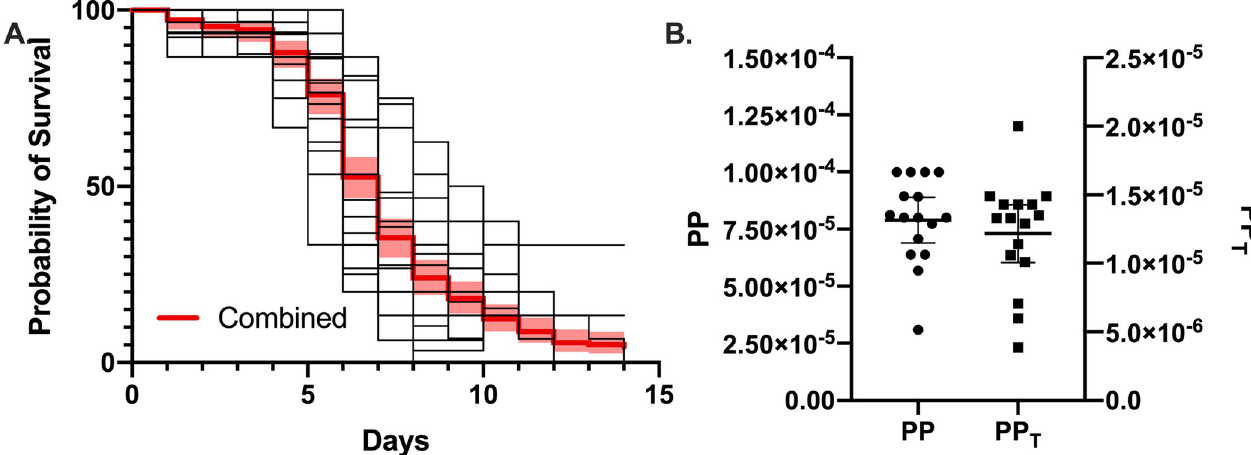
Fig 1. Pathogenic Potential of C. neoformans in G. mellonella. (A). Overlapping plots of the survival of G . mellonella infected with C . neoformans at an inoculum of 10 5 cells/larvae. Each of the 16 survival curves represents a replicate infection with 15 to 30 larvae. The red line indicates the combined survival curve with a 95% confidence interval. The individual pathogenic potential (PP) (B) and pathogenic potential in respect to time (PP T ) were calculated and plotted. Each data point in (B) represents the calculated PP or PP T of an individual experiment. Error bars represent mean with 95% confidence interval.